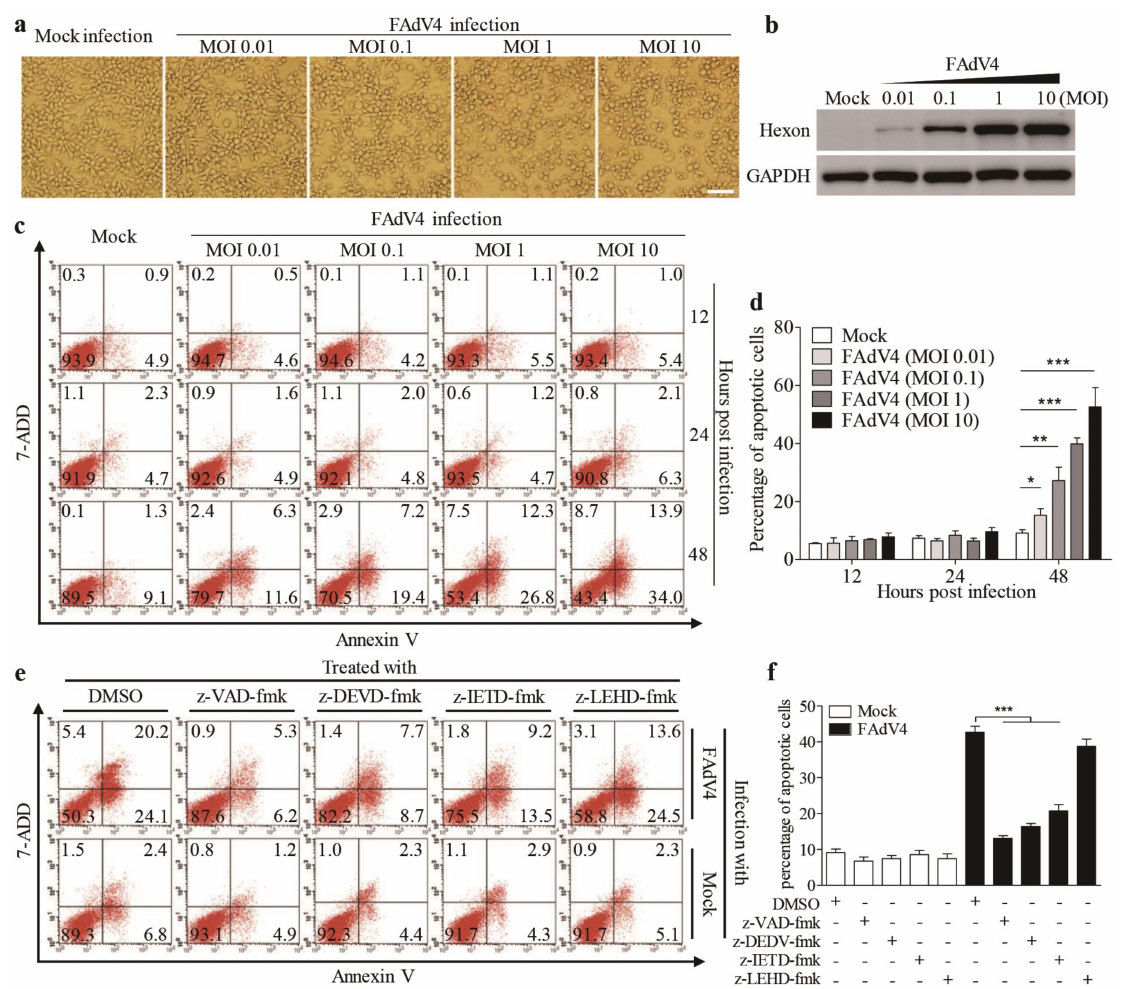
Figure 1. Fowl adenovirus serotype 4 (FAdV4) induced apoptosis in Leghorn male hepatocellular (LMH) cells. ( a ) FAdV4 infection caused a cytopathic e ff ect (CPE) in LMH cells. LMH cells were mock-infected or infected with FAdV4 at an increased MOI of 0.01, 0.1, 1 and 10. Thirty-six hours after infection, LMH cells were visualized under a microscope. The scale bar represents 100 µ m. ( b ) Examination of the hexon viral protein in FAdV4-infected cells by Western Blot. Forty-eight hours after FAdV4 infection, structural protein hexon was examined with a Western Blot using an anti-hexon specific antibody. ( c , d ) FAdV4 infection caused apoptosis in LMH cells. LMH cells were infected with FAdV4 at an increased MOI of 0.01, 0.1, 1 and 10. At di ff erent time points (12, 24 and 48h) after infection, cells were harvested, stained with Annexin V-PE and 7-AAD, and analyzed by flow cytometry. Mock-infected cells were used as controls. The percentage of apoptotic cells in ( c ) was quantified ( d ). ( e ) Inhibition of FAdV4-induced apoptosis by caspase inhibitors. LMH cells were seeded on 12-well plates and cultured overnight. Caspase inhibitors (z-VAD-fmk, z-DEVD-fmk, z-IETD-fmk and z-LEHD-fmk) were applied to cell culture for 2h prior to FAdV4 infection. Two hours after infection with FAdV4 at a MOI of 1, cells were cultured with indicated caspase inhibitors again. Forty-eight hours after infection, cells were harvested, stained with Annexin V-PE and 7-AAD, and analyzed by flow cytometry. The percentage of apoptotic cells in ( e ) was quantified ( f ). Results are representative of three independent experiments. Data are presented as mean ± SD, n = 3. The significance of di ff erences between the groups was performed by one-way ANOVA (* stands for p < 0.05, ** for p < 0.01, and *** for p <